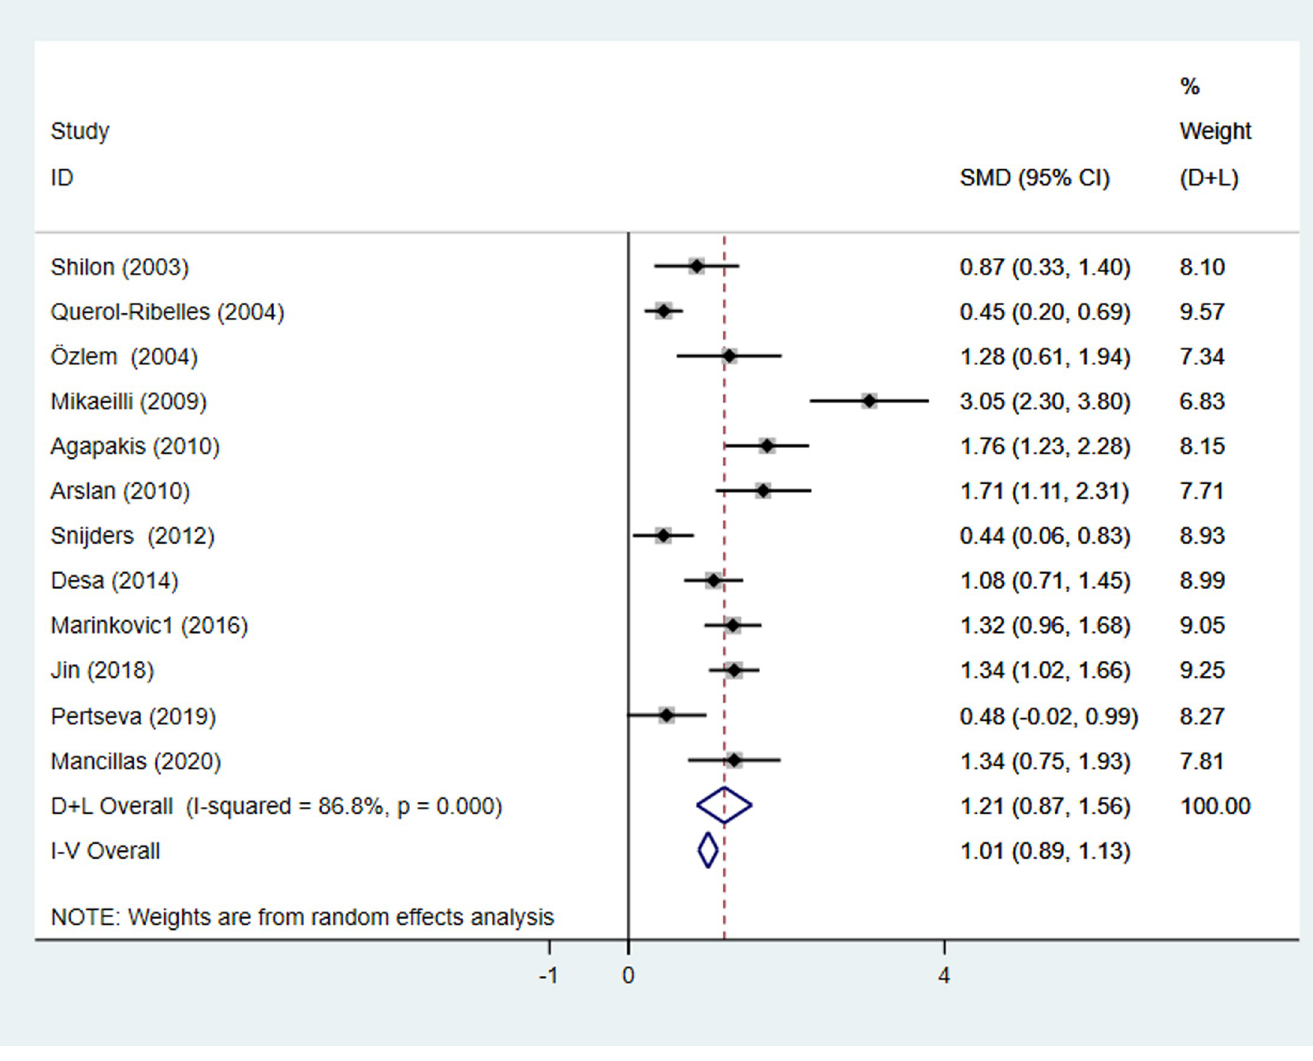
Fig 2. Forest plot of D-dimer in severe CAP versus non-severe CAP patients. The size of the square is proportional to study-specific statistical weights, horizontal lines represent 95% confidence interval (CI) and diamonds represent summary measures of association. SMD, standardized mean difference; ES, effect size. CAP, community- acquired